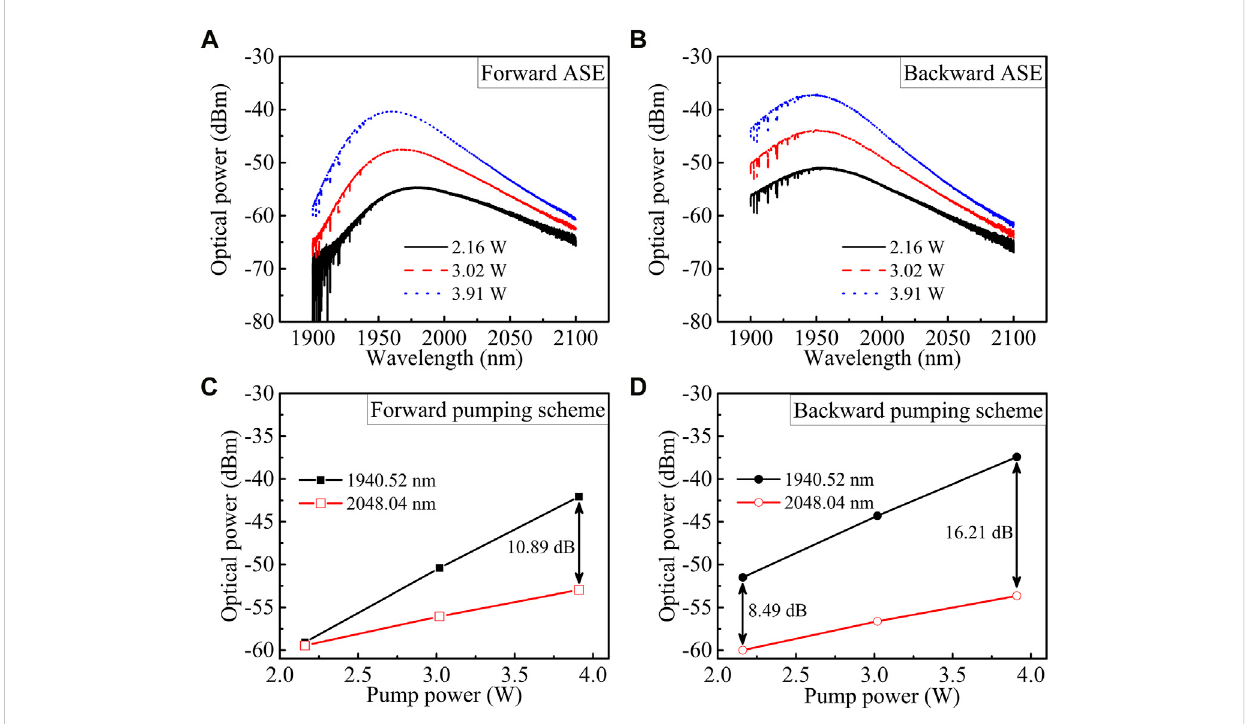
FIGURE 3 ASE spectra for different pump powers with a (A) forward and (B) backward pumping scheme. Optical powers at 1940.52 and 2048.04 nm for different pump powers with (C) forward and (D) backward pumping